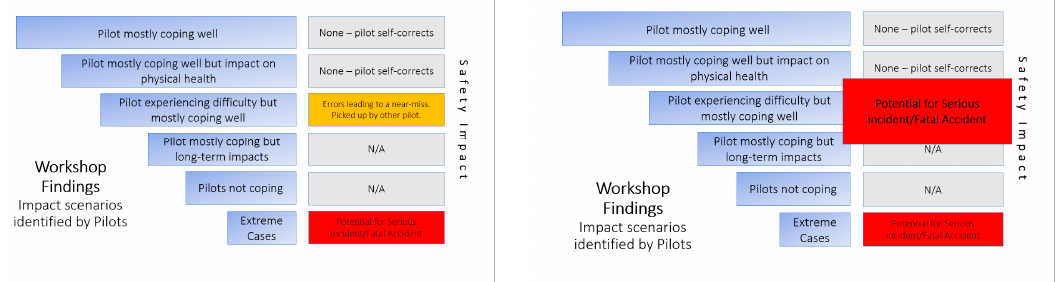
Figure 3. Impact scenarios. Figure 3 . Impact scenarios .